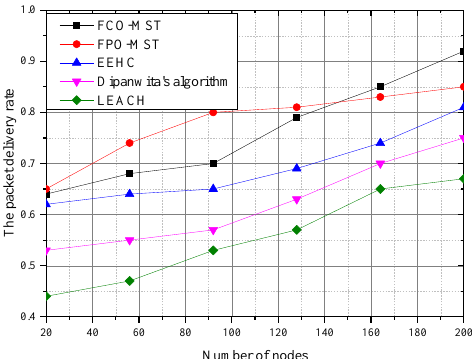
Figure 10. PDR vs. the number of nodes.